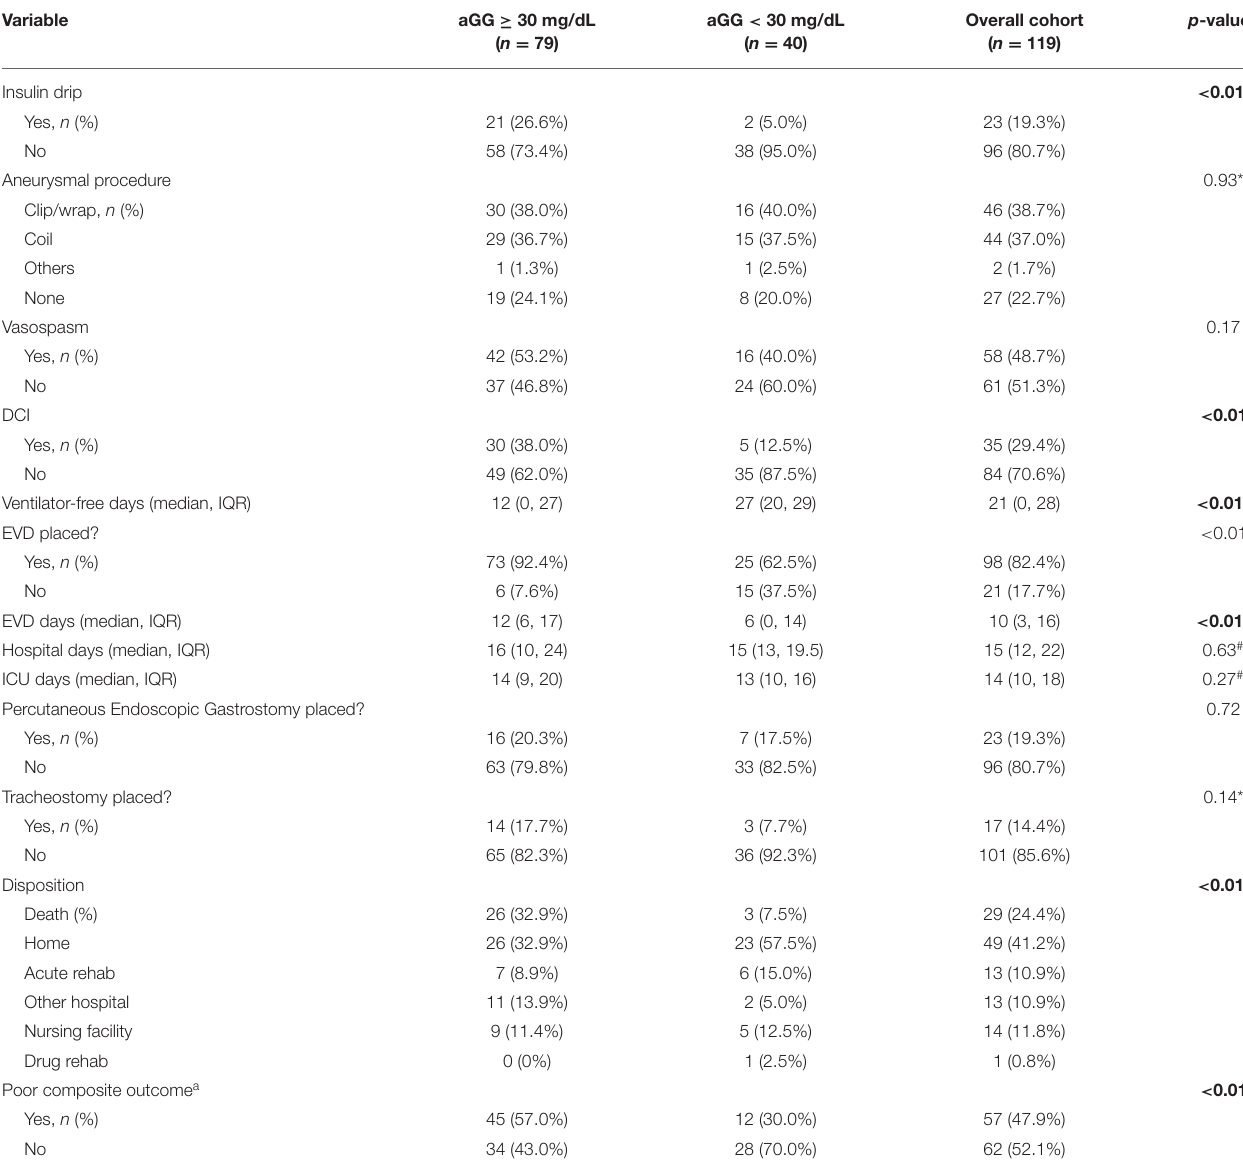
TABLE 3 | In-hospital outcomes between patients with elevated vs. non-elevated admission glycemic gap.